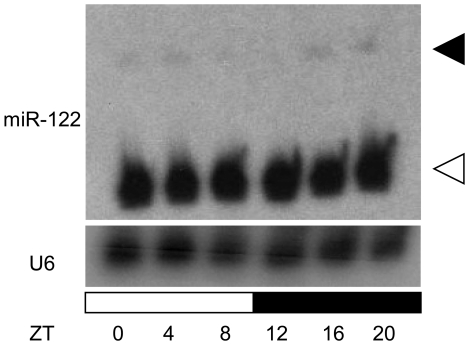
Mature miR-122 expression is not rhythmic in liver.The levels of miR-122 were determined by Northern blotting from liver samples taken at various circadian times as indicated. One mouse per time point was used. U6 snRNA was measured as a loading control. White and black arrowheads indicate mature miR-122 and pre-miR-122, respectively.